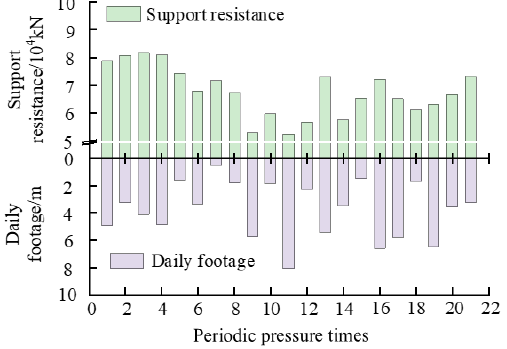
Figure 13. The average support resistance and daily footage during periodic pressure.